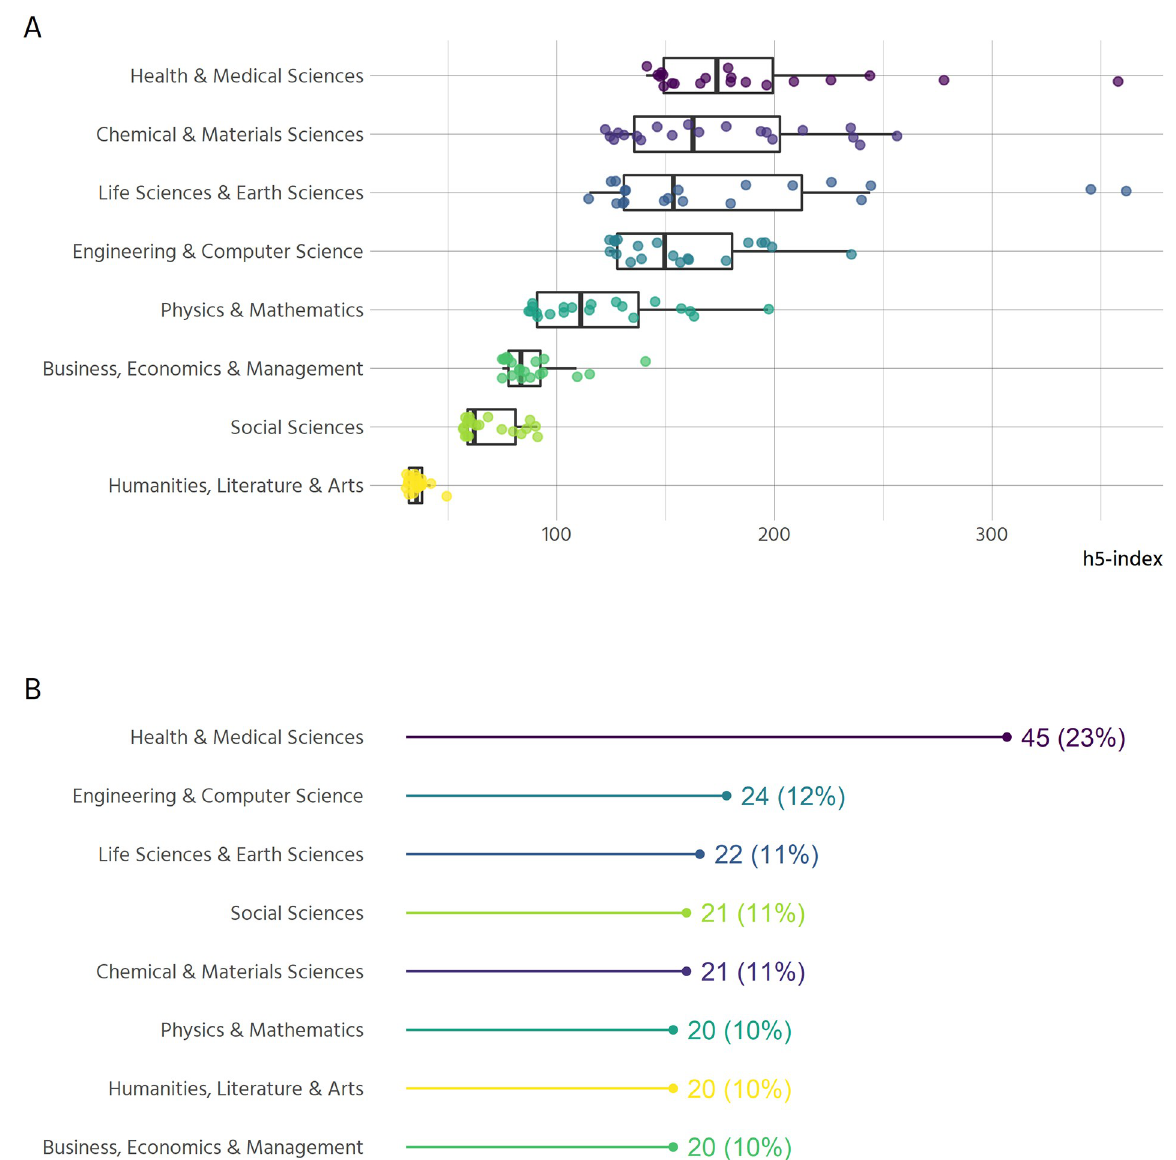
Fig 7. Sample characteristics. (A) The distribution of journal’s h5-indices across disciplines (n = 171). (B) Number and proportion of journals sampled by discipline (n = 193).